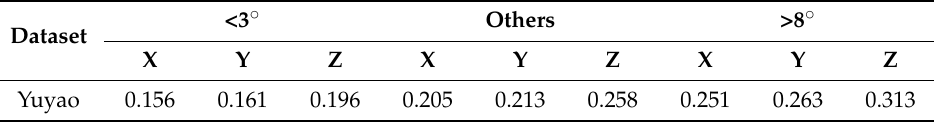
Table 7. Errors of control points in different stereo models for